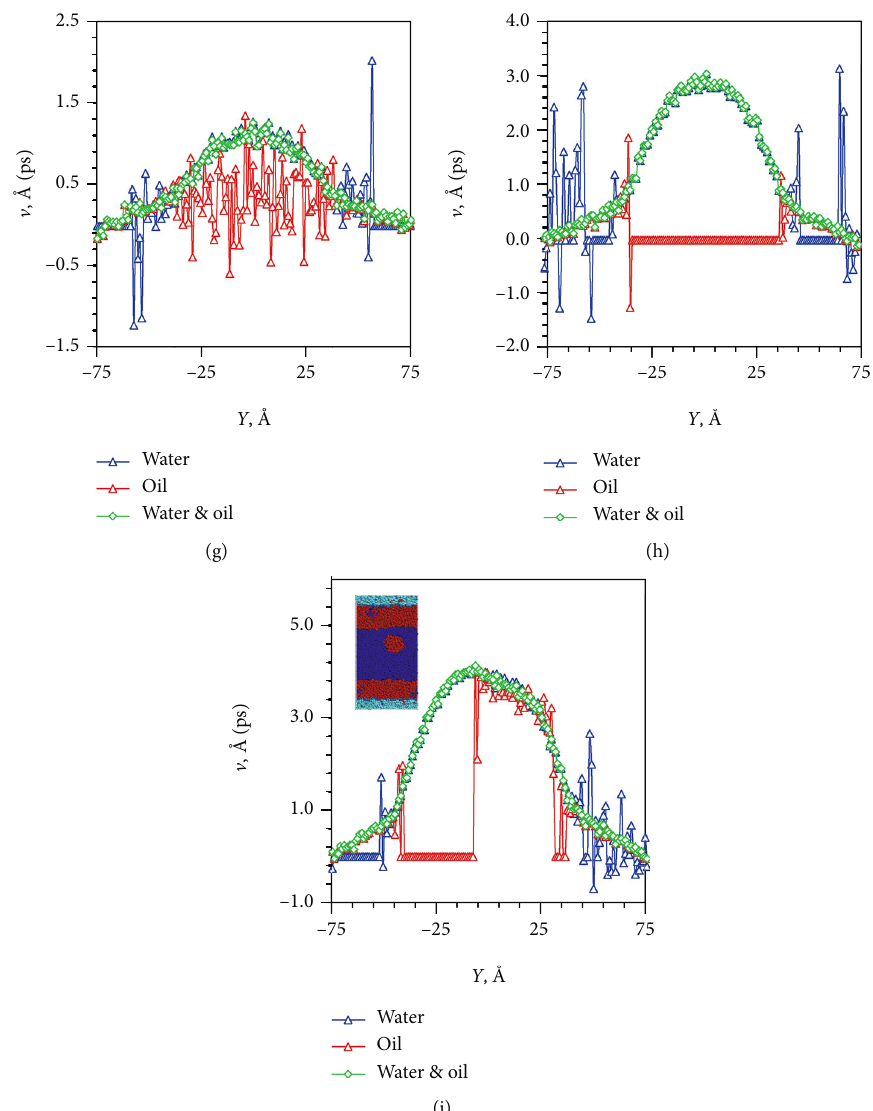
Figure 6: Velocity pro fi le along the X -axis: (a – c) models 1 – 3; (d – f) models 4 – 6; (g – i) models 7 –